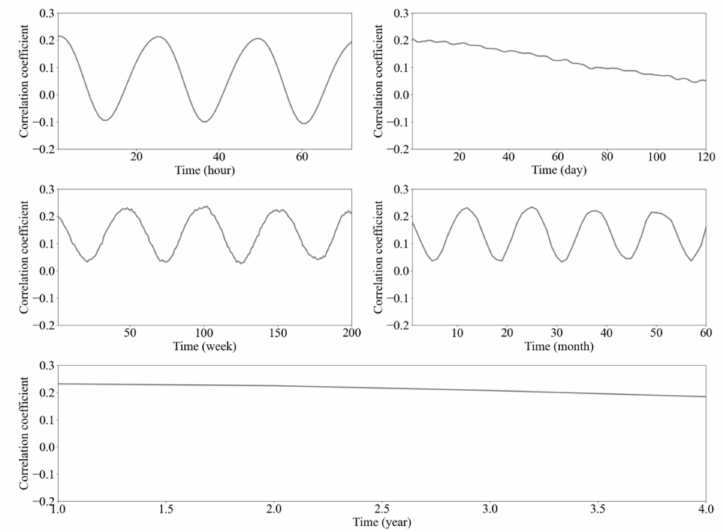
Figure 2. Pearson correlation coefficient between load and lagged temperature data corresponding to hour, day, week, month, and year.